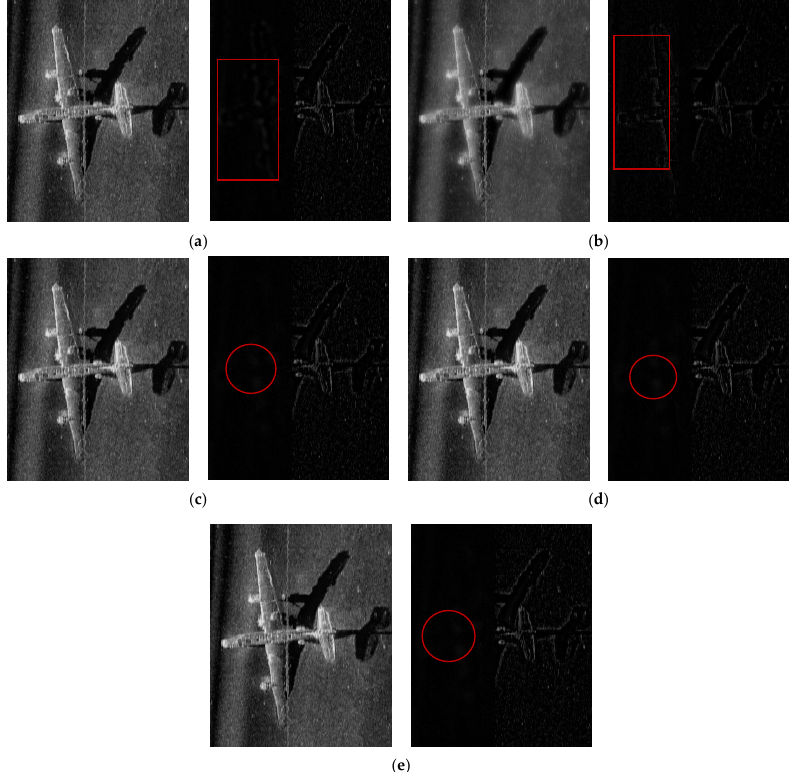
Figure 8. Fused image (left) and difference image (right) of Data 1. ( a ) Energy_Max. ( b ) Dire_Contrast_Max. ( c ) PCNN (NSML). ( d ) Improved DPCNN (IDPCNN) (modified spatial frequency (MSF)). ( e ) IDPCNN (NSML).